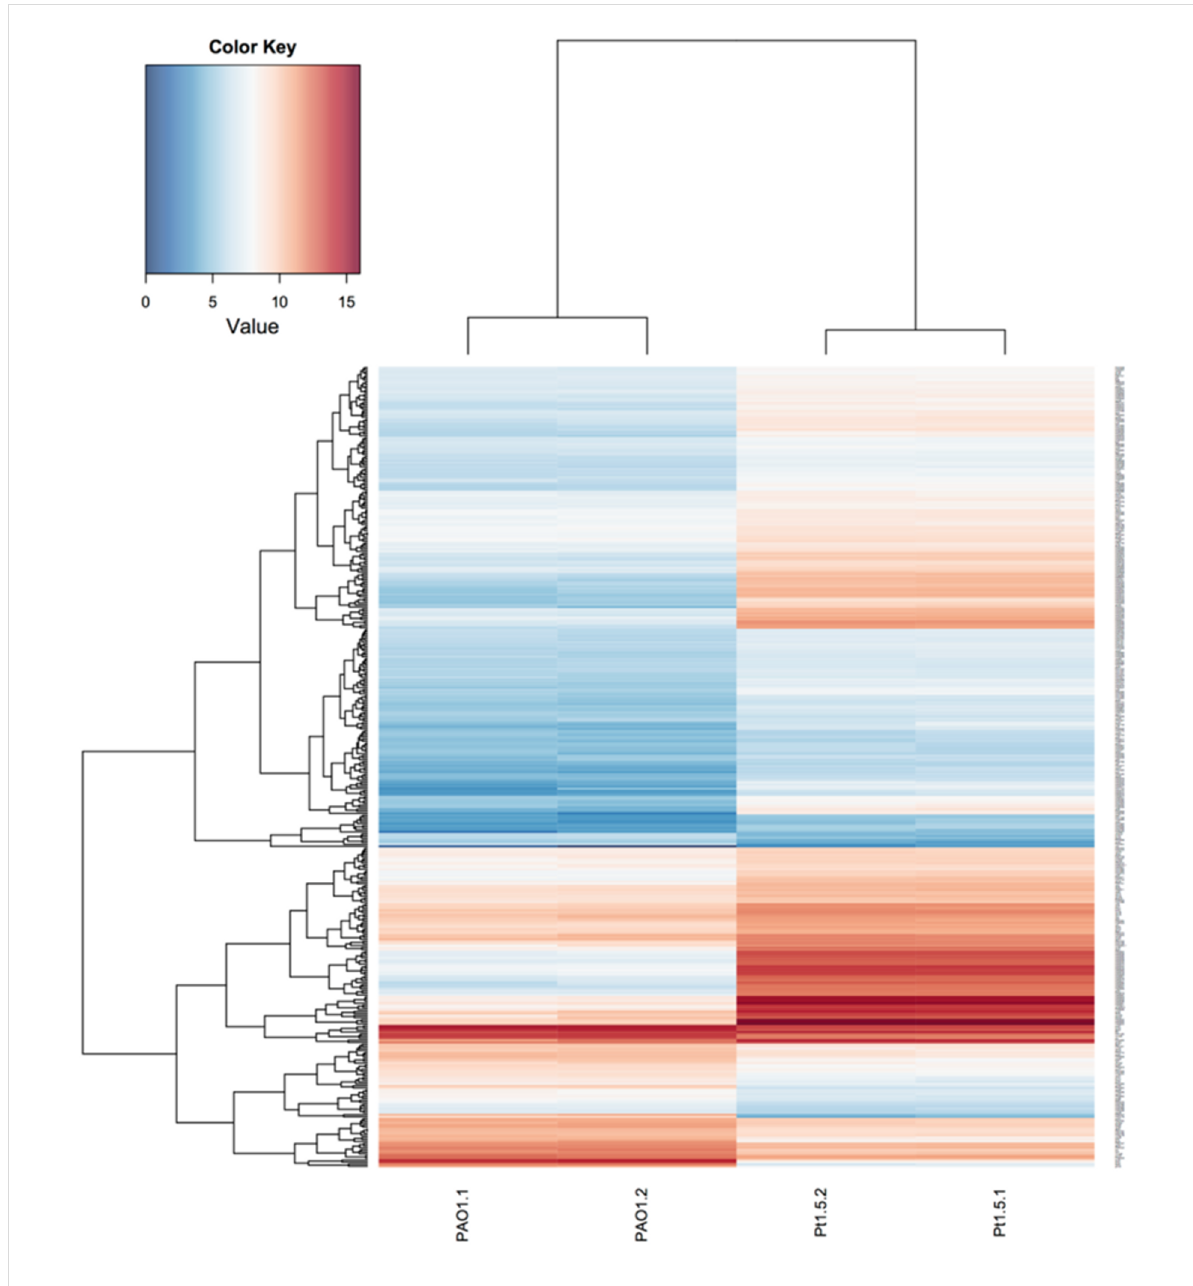
Figure 2: Transcriptomic analysis of control and cisplatin-treated PAO1 cultures. Heatmap comparing the transcriptomes of control and cisplatin- treated PAO1 cultures.